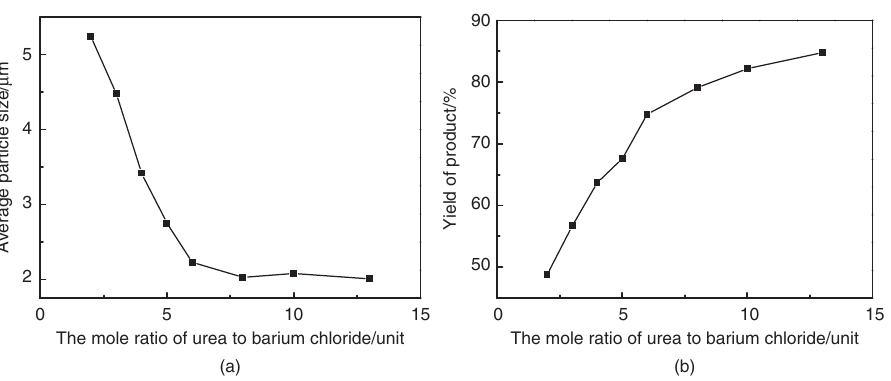
Figure 3: Effect of (NH 2 ) 2 CO concentration on average particle size (a) and yield of product (b) in the microwave homogeneous precipitation, respectively.